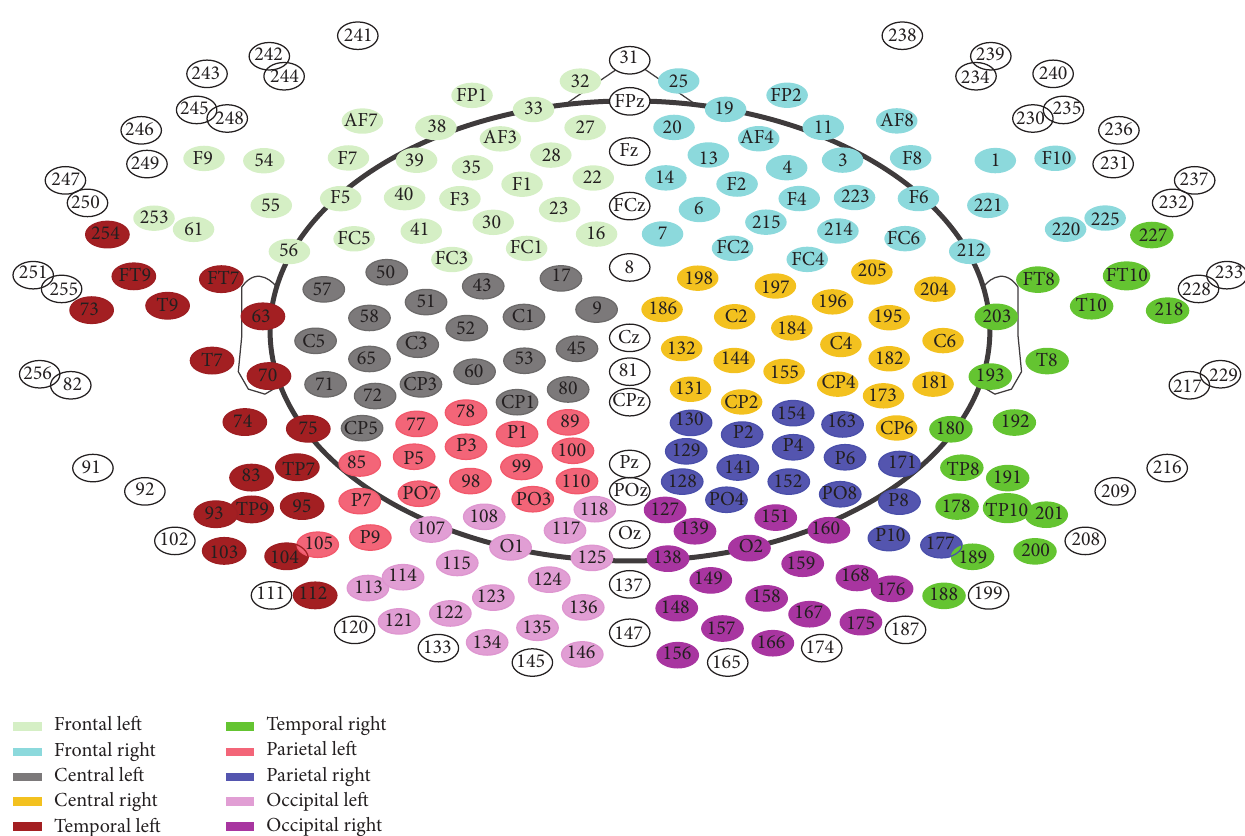
Figure 4: Electrodes allocation for frequency analyse